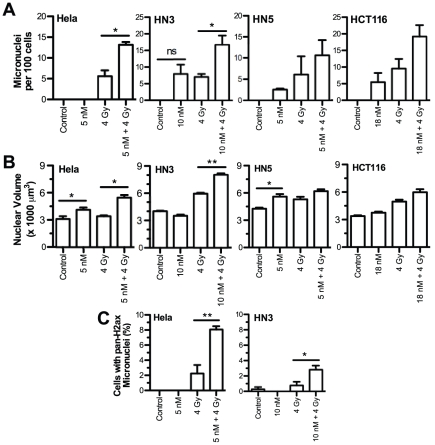
NVP-AUY922 in combination with radiation increases micronuclei formation and nuclear volume.The cell lines indicated were treated with vehicle only or NVP-AUY922 for 24 h before mock irradiation or irradiation with 4 Gy. 48 h post-irradiation cells were fixed and nuclei stained with DAPI. (A) Nuclear morphology was imaged by Z-stack confocal microscopy and the presence micronuclei of quantified for 100 cells. (B) 3-dimensional nuclear topography was constructed using Volocity image processing and analysis software and utilised to quantify increased nuclear volume due to ionising radiation and NVP-AUY922 in 150 nuclei. (C) Confocal images at 24 h used for phospho-H2ax foci formation in figure 4 were quantified for pan-phospho-H2ax staining present in micronuclei. Values shown for quantification of a minimum of 100 nuclei. All values shown are for three independent experiments ± SEM with statistical analysis by student t-test between the groups indicated, *p<0.05, **p<0.01.